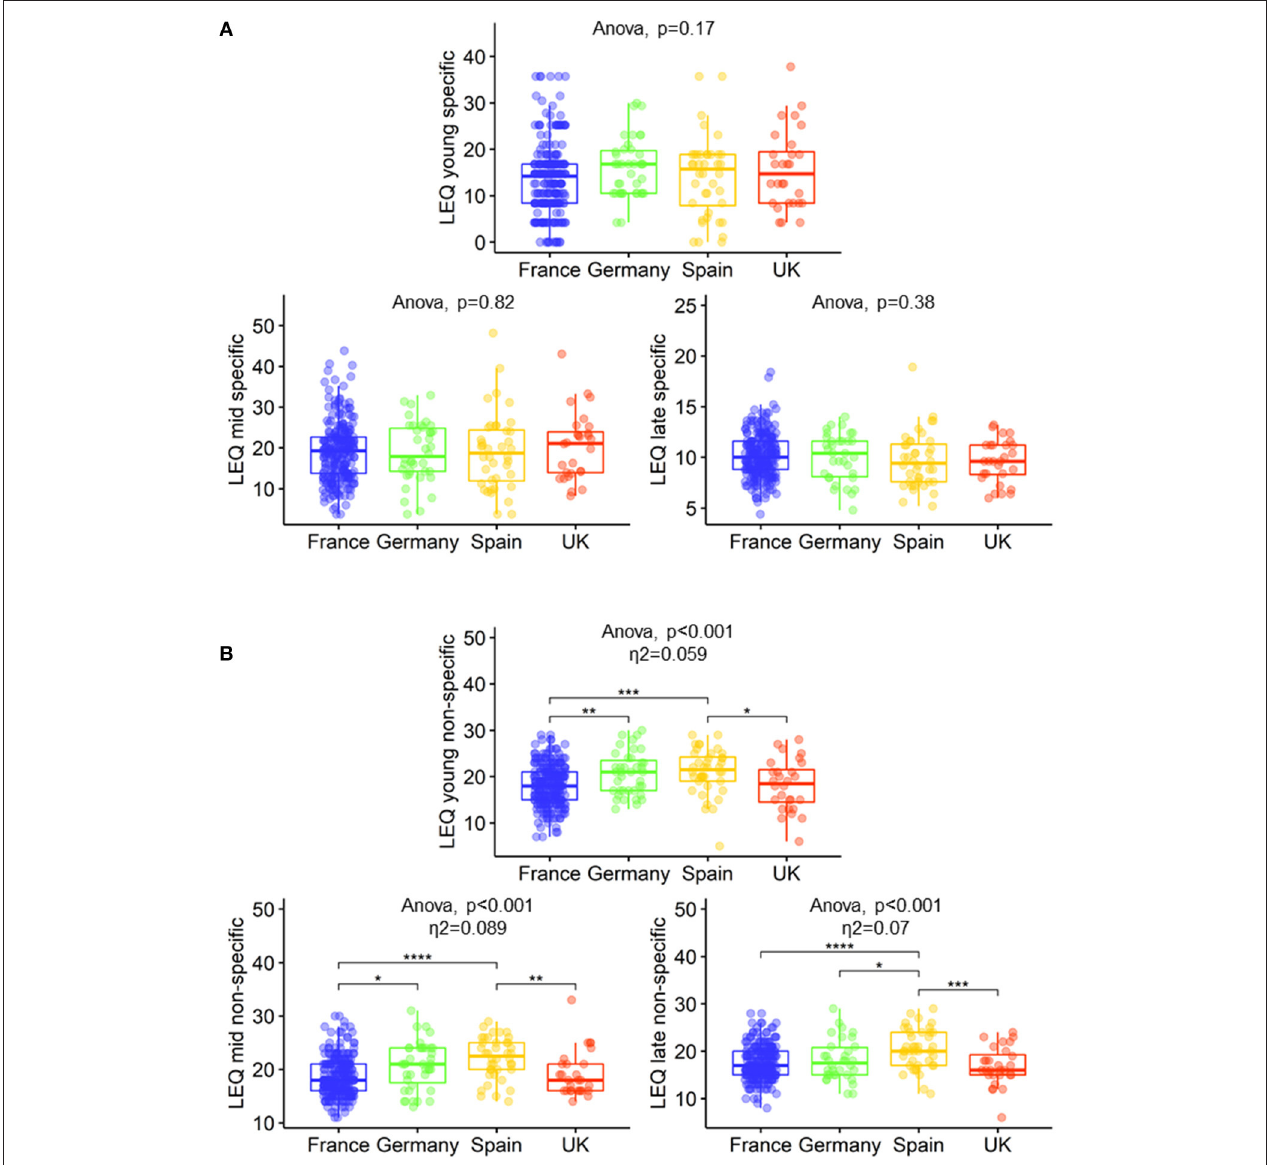
FIGURE 4 | Between-country differences in education and occupation (A) and leisure activities engagement (B) of the LEQ. Boxplots show the 25th, 50th, and 75th percentiles within each country. Tukey Honestly Significant Difference (HSD) was used as a post hoc test: * P < 0.05, ** P < 0.01, *** P < 0.001, **** P < 0.0001. LEQ, Lifetime of Experiences Questionnaire; UK, United